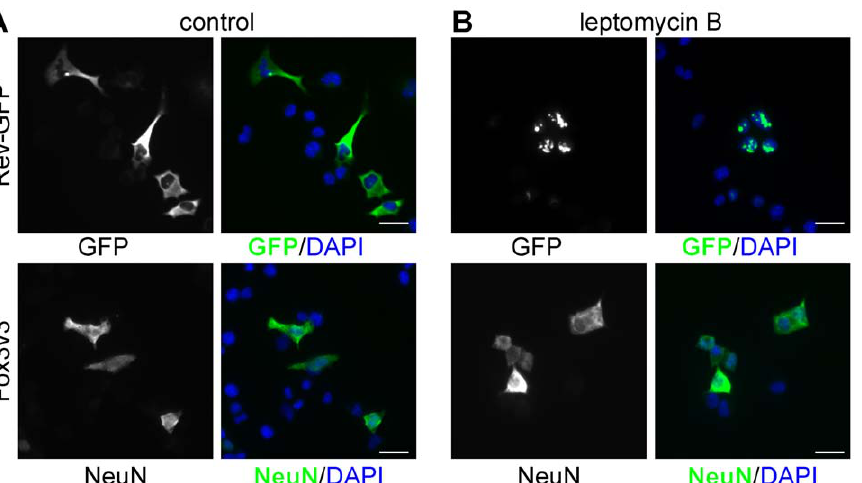
Figure 7. NeuN (Rbfox3) nuclear export is not Crm1/exportin 1-dependent. Rev-GFP fusion protein or Rbfox3 variant 3 with an N-terminal flag-tag were expressed in N2A cells and (A) left untreated or (B) treated with 10 ng/ml leptomycin B for 4 hrs prior to fixation and staining with anti- NeuN and DAPI, or just DAPI in the case of Rev-GFP. Leptomycin B treatment caused Rev-GFP to be retained in the nucleus, but caused no change in the sub-cellular localization of Fox3v3.